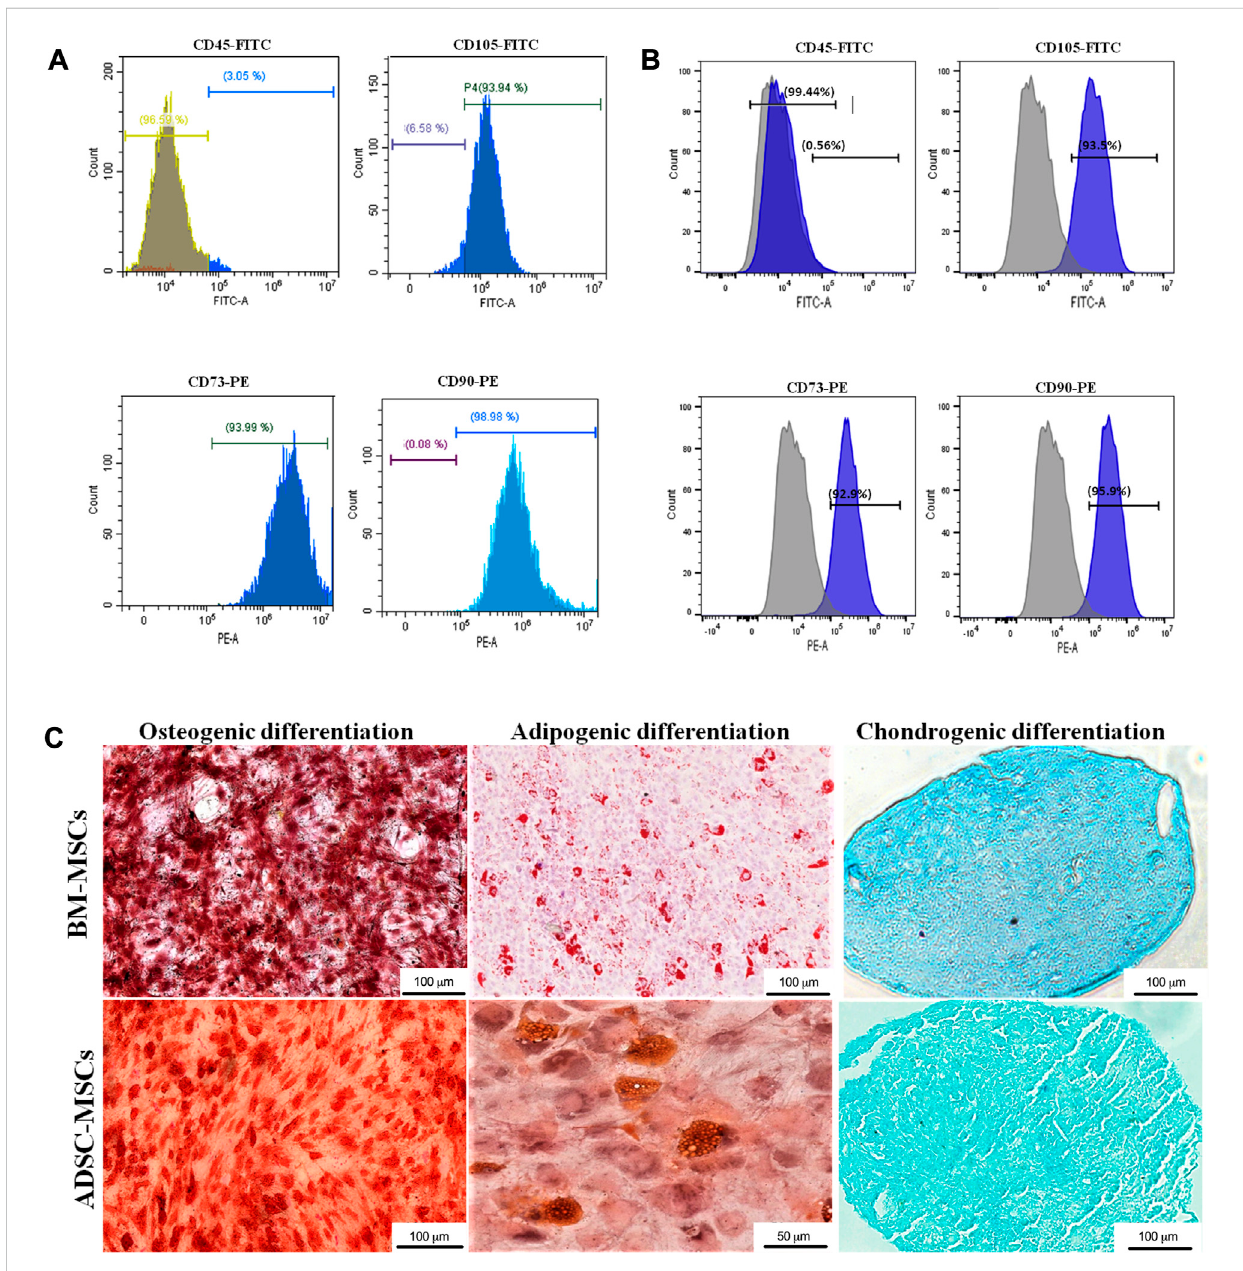
FIGURE 2 Characterization of MSCs. BM-MSCs (A) and ADSCs (B) where characterized with fl ow cytometry through immunophenotype analysis of MSC cell surfacemarkers CD45, CD105,CD73, CD90. (C) Osteogenic,adipogenic,